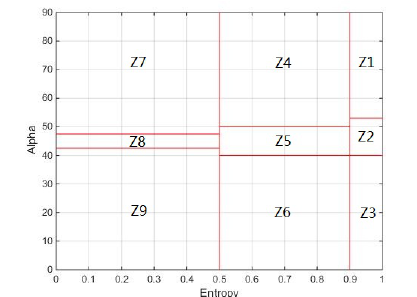
Figure 10. Entropy-alpha plane and categories of the entropy- alpha unsupervised classification (Cloude & Pottier, 1997) In the filtered TerraSAR-X data, a vegetation area and a double bounce area are selected according to the optical image of the same area, which belong to class Z5 and Z7 respectively. The entropy-alpha of each pixel in the two areas filtered by the eight filters are mapped into the entropy-alpha plane as depicted in Figure 11, which is then used to evaluate their performance concerning polarimetric information preservation.